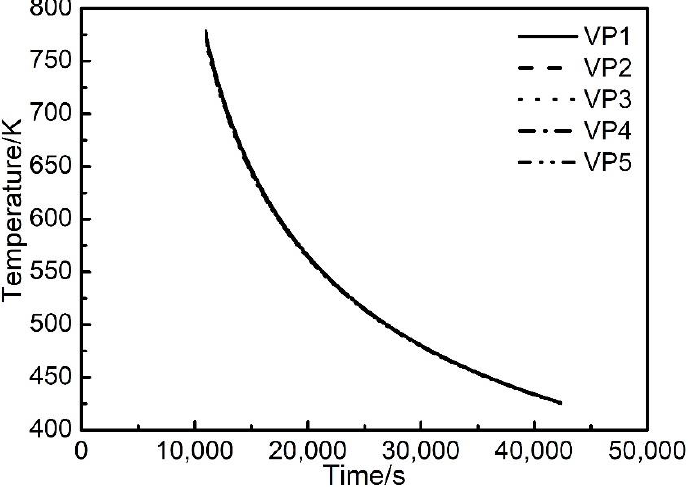
Figure 8. Evolution of temperature of the part at the five vertical sampling points with time during natural cooling process post manufacturing.